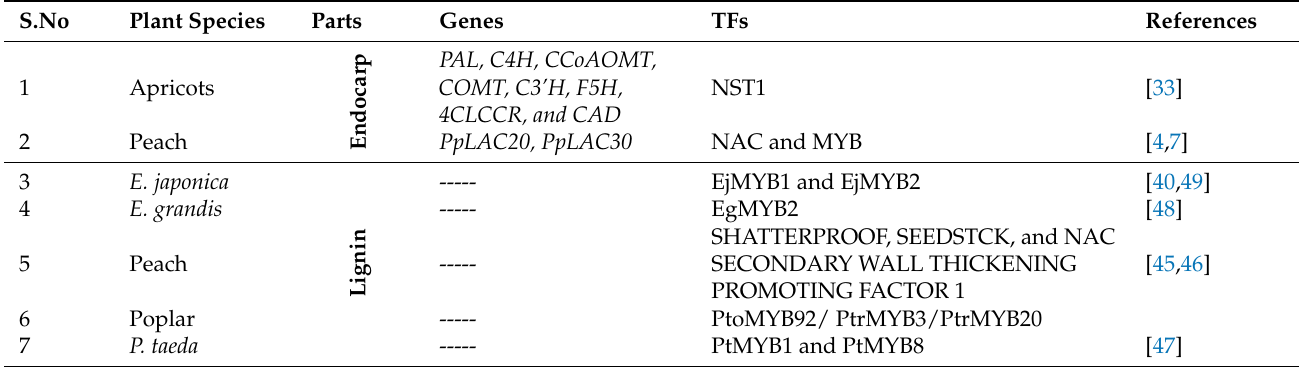
Table 1. Molecular regulation of endocarp and lignin formation in